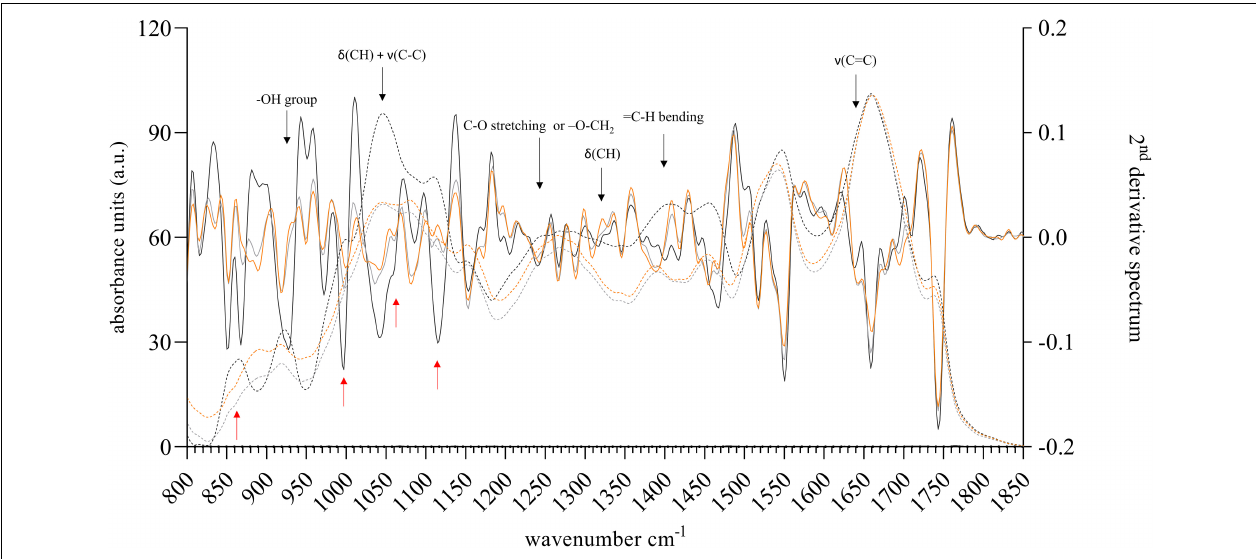
FIGURE 2 | FTIR spectra (dashed line) and 2nd derivative spectra (solid line) of biomass derived from Chlorococcum sp. (MC1) harvested after growth for 5 days in the presence of glycerol (2.3 g L − 1 , light gray or 20 g L − 1 , dark gray). The control culture (orange) was grown photoautotrophically in the absence of external carbon source. Black arrows indicate bands typically arising by the carbon source. Red arrows highlight the most prominent changes in the 2nd derivative spectra compared to the control. These cannot be assigned to glycerol.